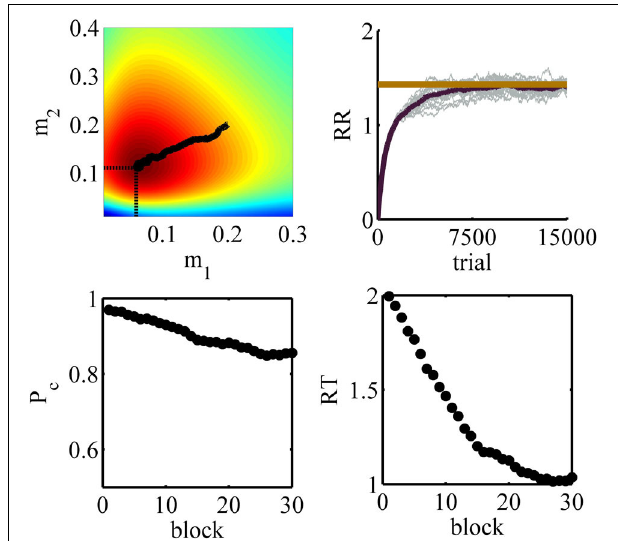
FIGURE 11 | Results of simulation 2. Top left: the values of the parameters m 1 and m 2 during learning averaged over 20 simulations superimposed on the color map of the average reward rate. The initial point (cid:5) (cid:6) = (0 . 2 , 0 . 2) and its end point is (cid:5) of the path is m 1 (1) , m 2 (1) (cid:6) = (0 . 06 , 0 . 11) . The optimal value is indicated by the m 1 (15000) , m 2 (15000) two dash lines. Top right: the estimated average reward rate. The optimal value is plotted as a red tick line. Bottom left: the accuracy as a function of block number. Bottom right: the mean reaction time as a function of block